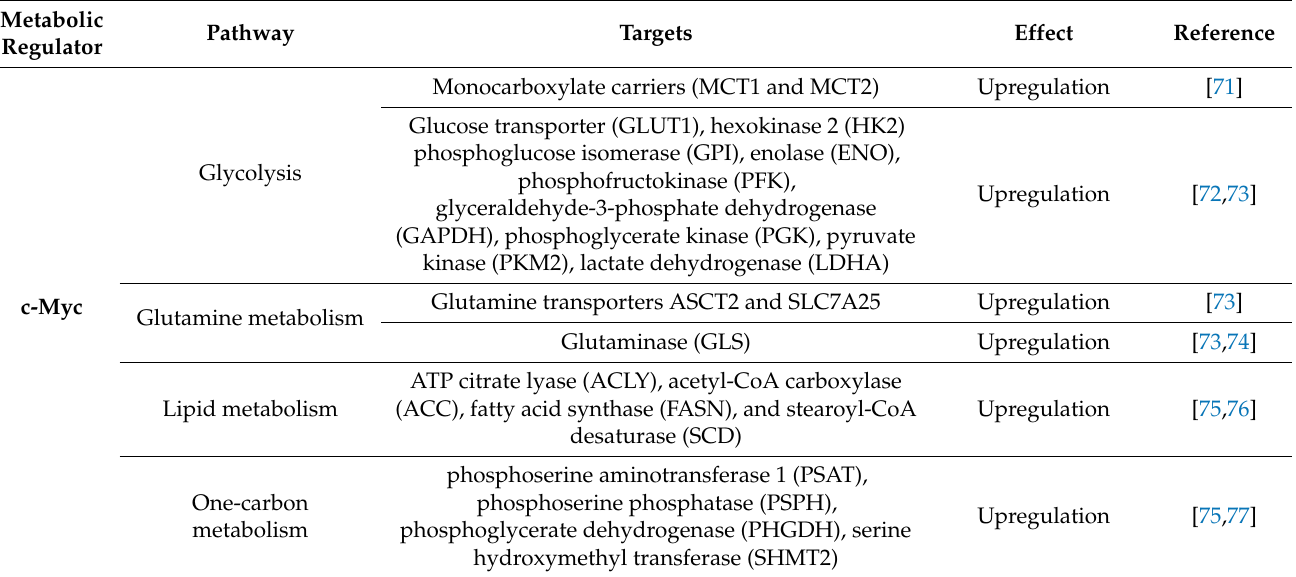
Figure 2. Several examples of the oncogene-mediated regulation of metabolic reprogramming. AKT upregulates oncogenic c-Myc and HIF1 and concomitantly downregulates the tumor suppressor FoxO. In turn, transcription factors HIF1, c- Myc, and FoxO (marked by specific geometric figures) regulate expression levels of enzymes indicated. ENO—enolase; PFK—phosphofructokinase; PK—pyruvate kinase; ASCT2—Solute Carrier Family 1 Member 5; PSAT—phosphoserine aminotransferase; PSPH—phosphoserine phosphatase; SHMT2—Serine Hydroxymethyltransferase 2; CAD—Carbamoyl- Phosphate Synthetase 2; Aspartate Transcarbamylase, And Dihydroorotase. Table 1. Key metabolic regulators and their effects on some of their